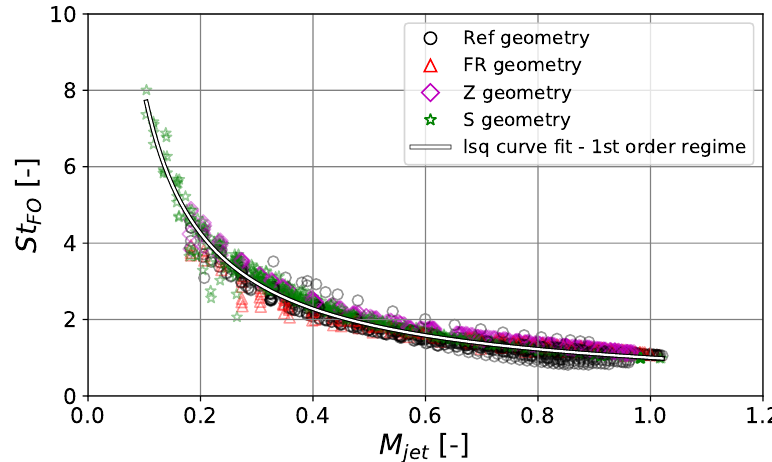
Figure 15. Non-dimensional characteristic of the used FO-PJA family, first-order regime.